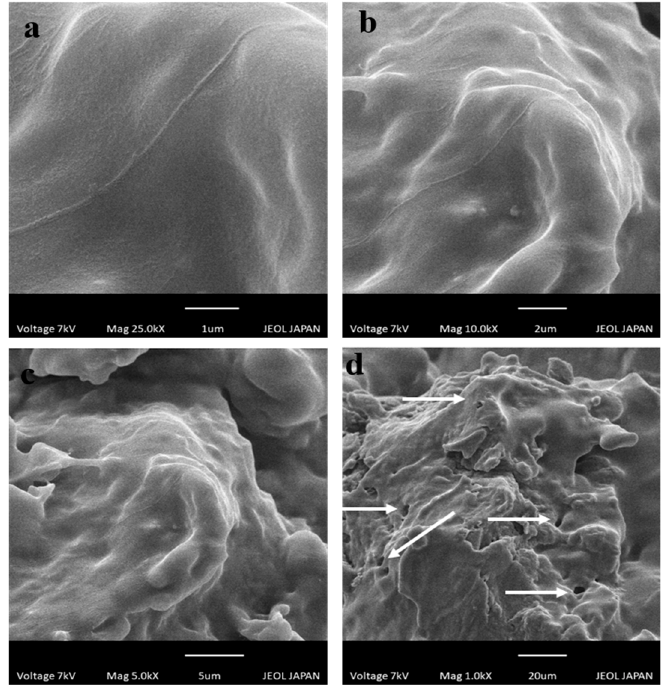
Figure 5. SEM photomicrographs of chitosan/fenugreek ‐ g ‐ poly (MAA) hydrogels at ( a ) 25 KX, ( b ) 10 KX, ( c ) 5 KX, and ( d ) 1 KX magnifications.